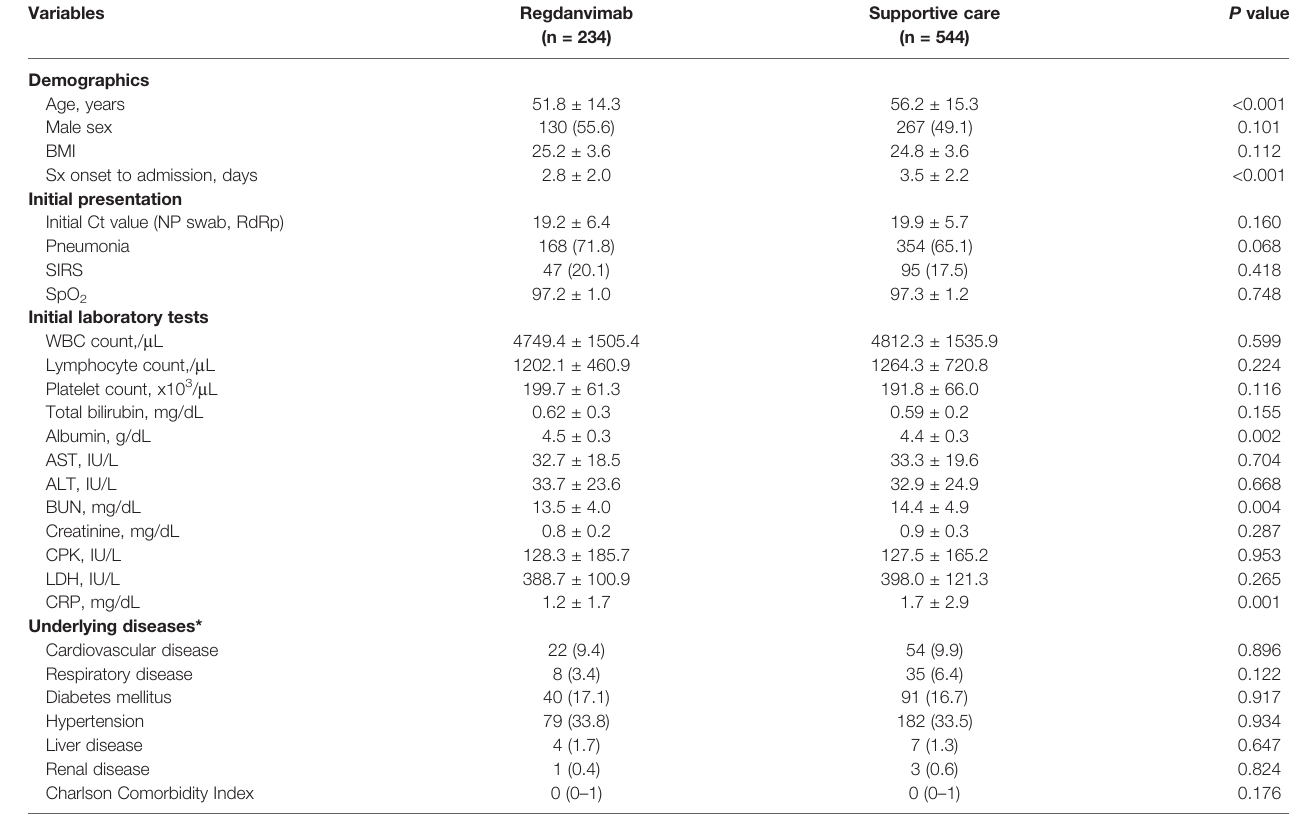
TABLE 1 | Baseline characteristics of the regdanvimab and supportive care groups. Variables